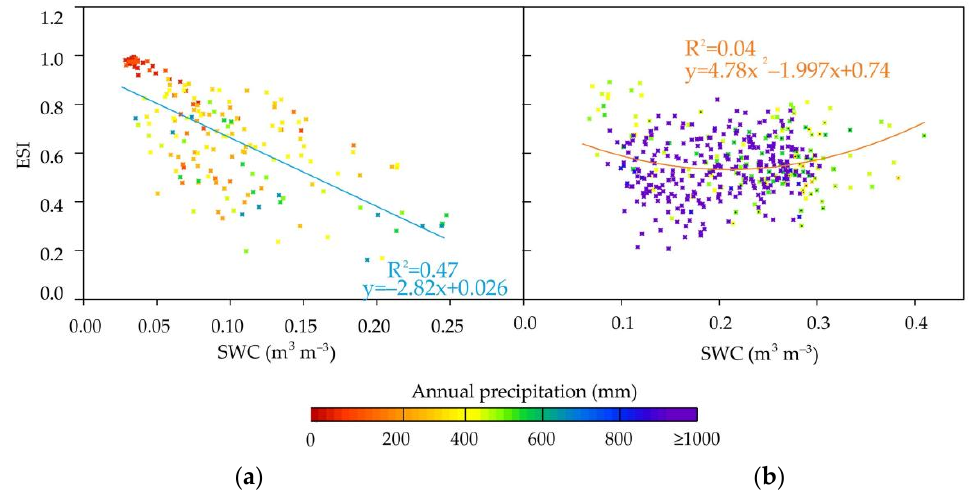
Figure 9. Variation of ESI with SWC in different precipitation zones. ( a ) is the data of SQH, NM and SACOL stations with the annual precipitation is lower than 400 mm, and the blue line is the fitting line of the scattered points and ( b ) is the data of other stations. Additionally, the orange line is the fitting line of the scattered points. Figure 11 is similar to Figure 9.